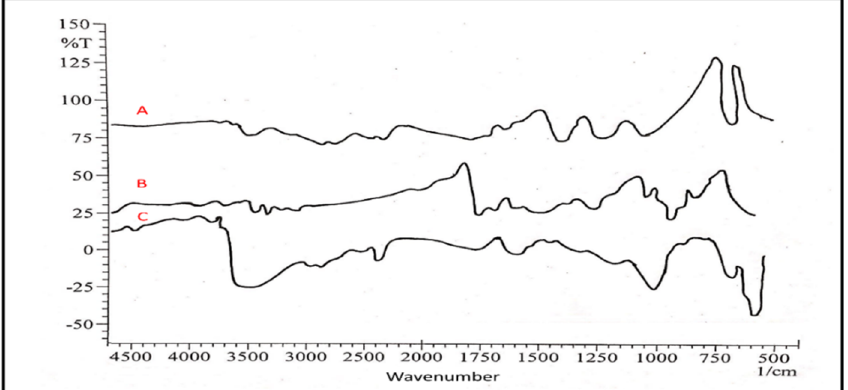
Figure 1. Phase solubility diagram of FA and CBZ at room temperature (25 ± 2 °C).